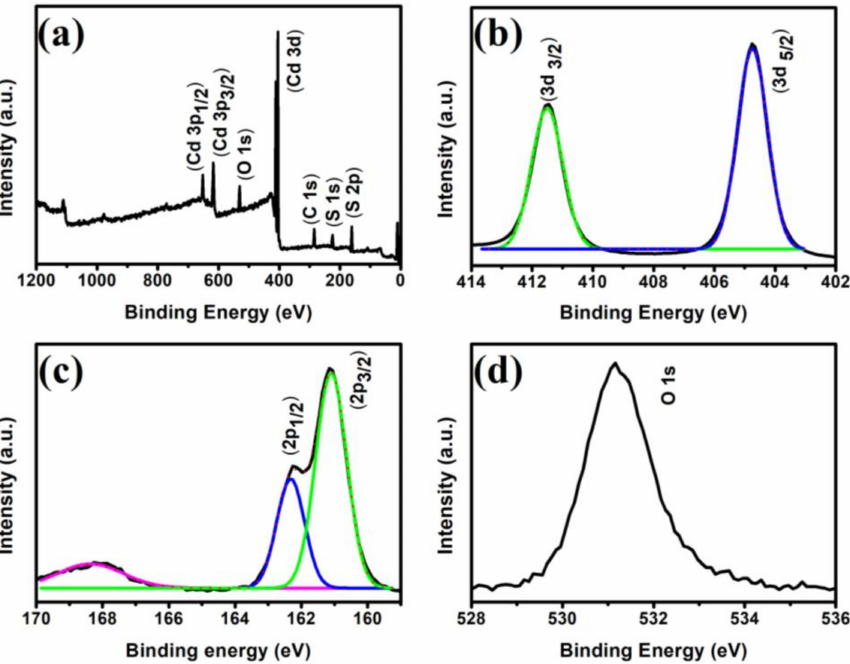
Figure 6. XPS survey spectrum of CdS NRs ( a ), high-resolution XPS spectra of Cd 3d ( b ), S 2p ( c ), and O 1s ( d